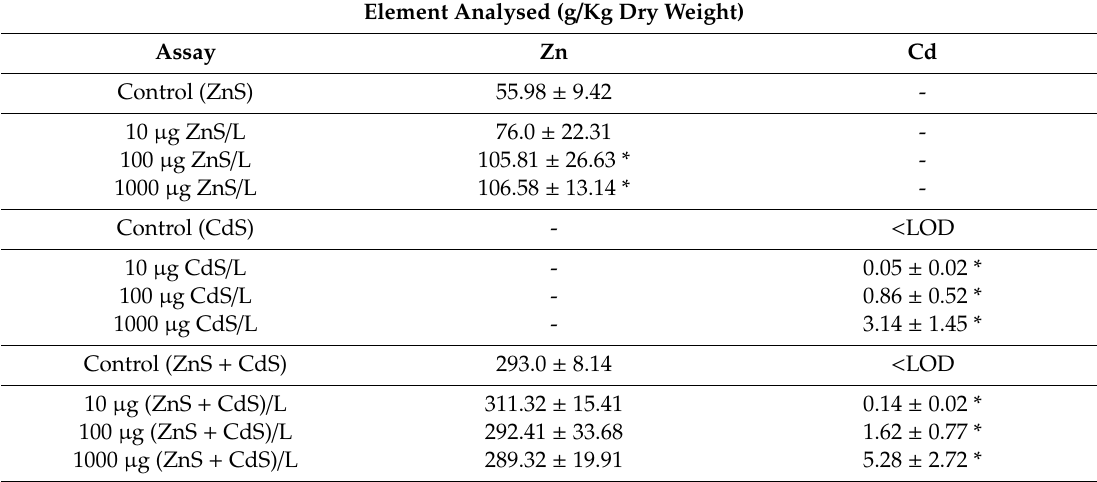
Table 3. Results from ICP-AES analysis of Zn and Cd in whole fish tissues exposed to the di ff erent concentrations of QDs (singly and